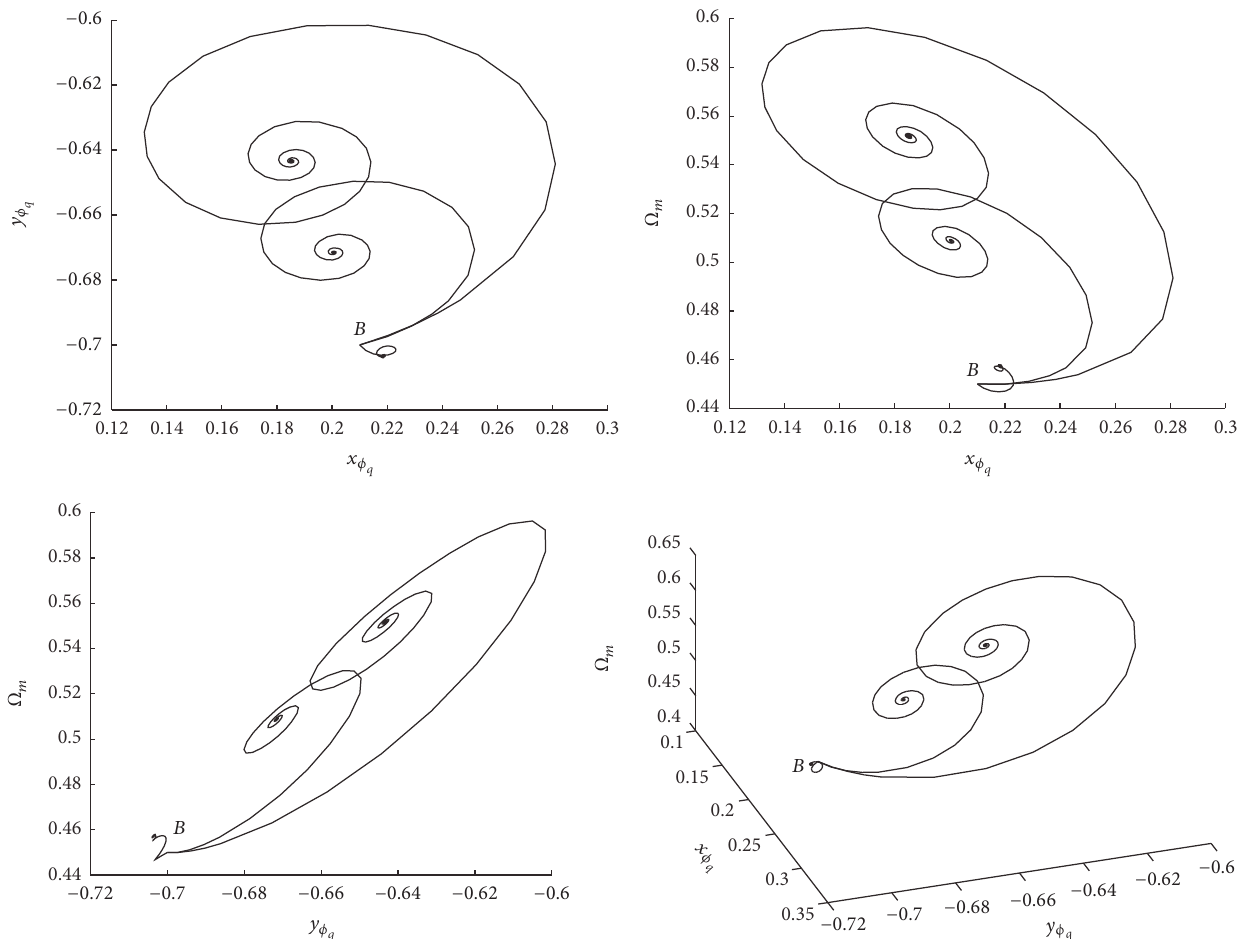
Figure 2: Two- and three-dimensional projections of the phase-space trajectories for 𝛽 = 2.51 , 𝜆 = 3.1 , 𝜆 = 3.6 , and 𝜆 = 4.1 . All plots begin from the critical point 𝐵 = (0.21,−0.70,0.45, 0) being a stable attractor.